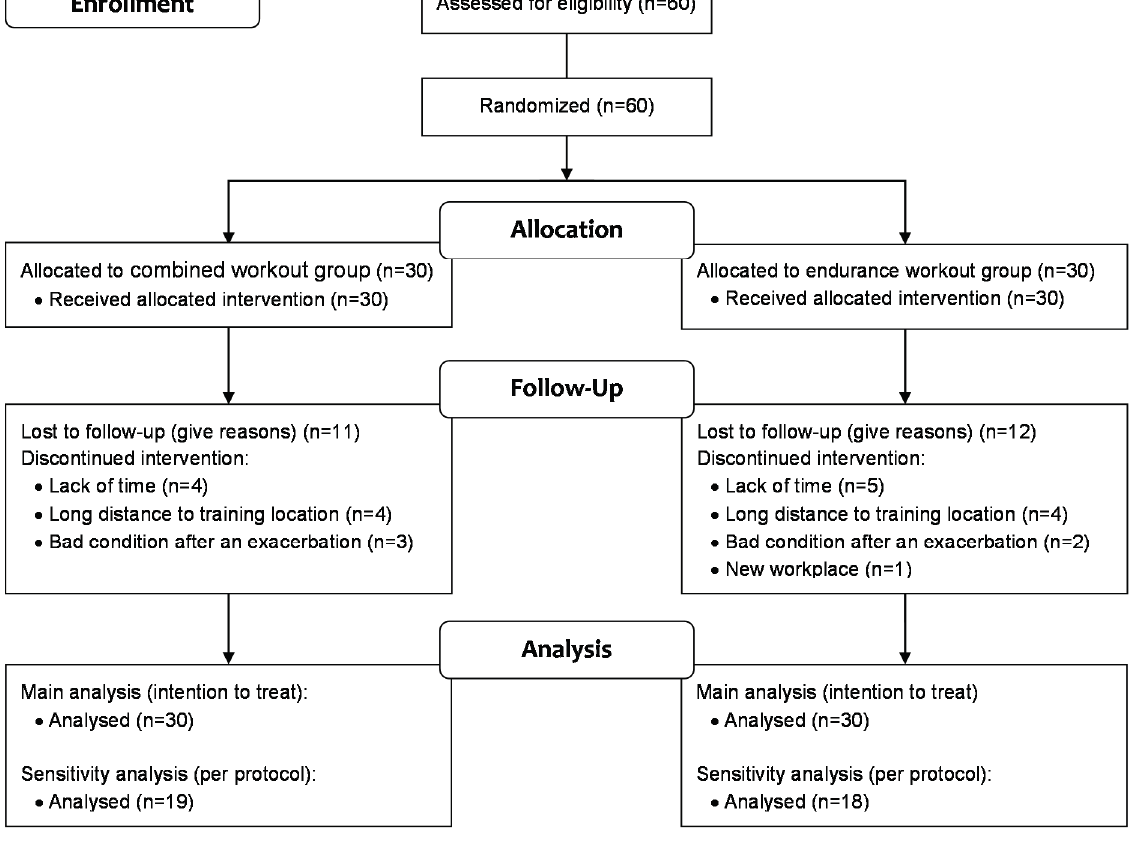
Figure 1. Flow chart of drop